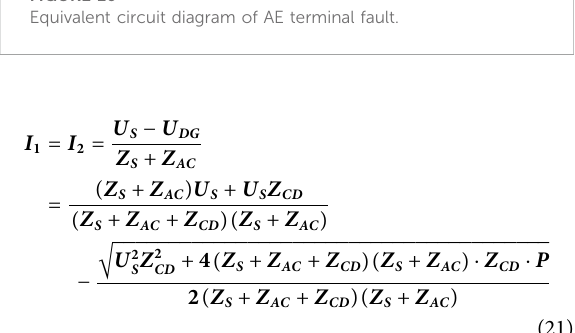
FIGURE 16 Equivalent circuit diagram of AE terminal fault.